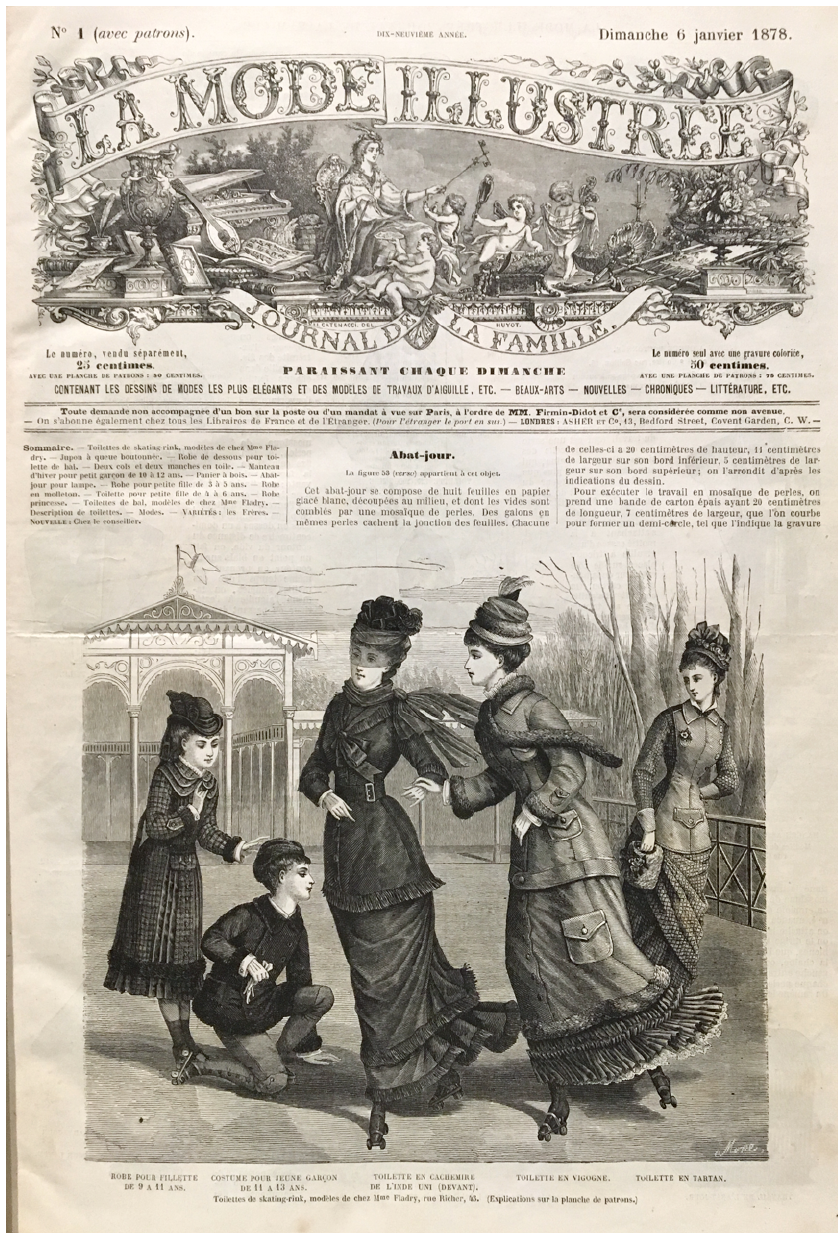
Fig. 2 Front cover of La Mode illustrée (January 1878), image courtesy of Kent State University